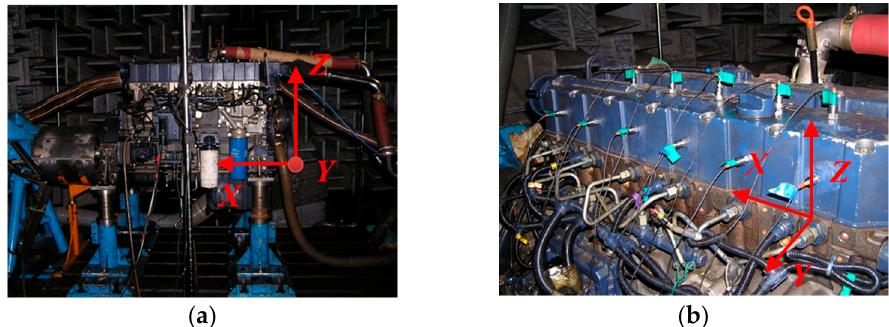
Figure 7. Bench test setup: ( a ) side view of test rig; ( b ) accelerometer arrangement. Table 1. Main specifications of the diesel engine used.